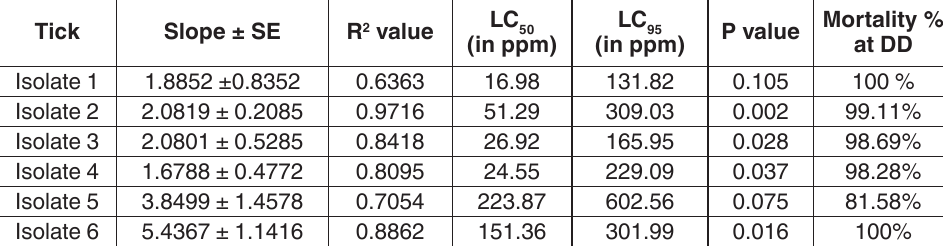
Isolate 4 Isolate